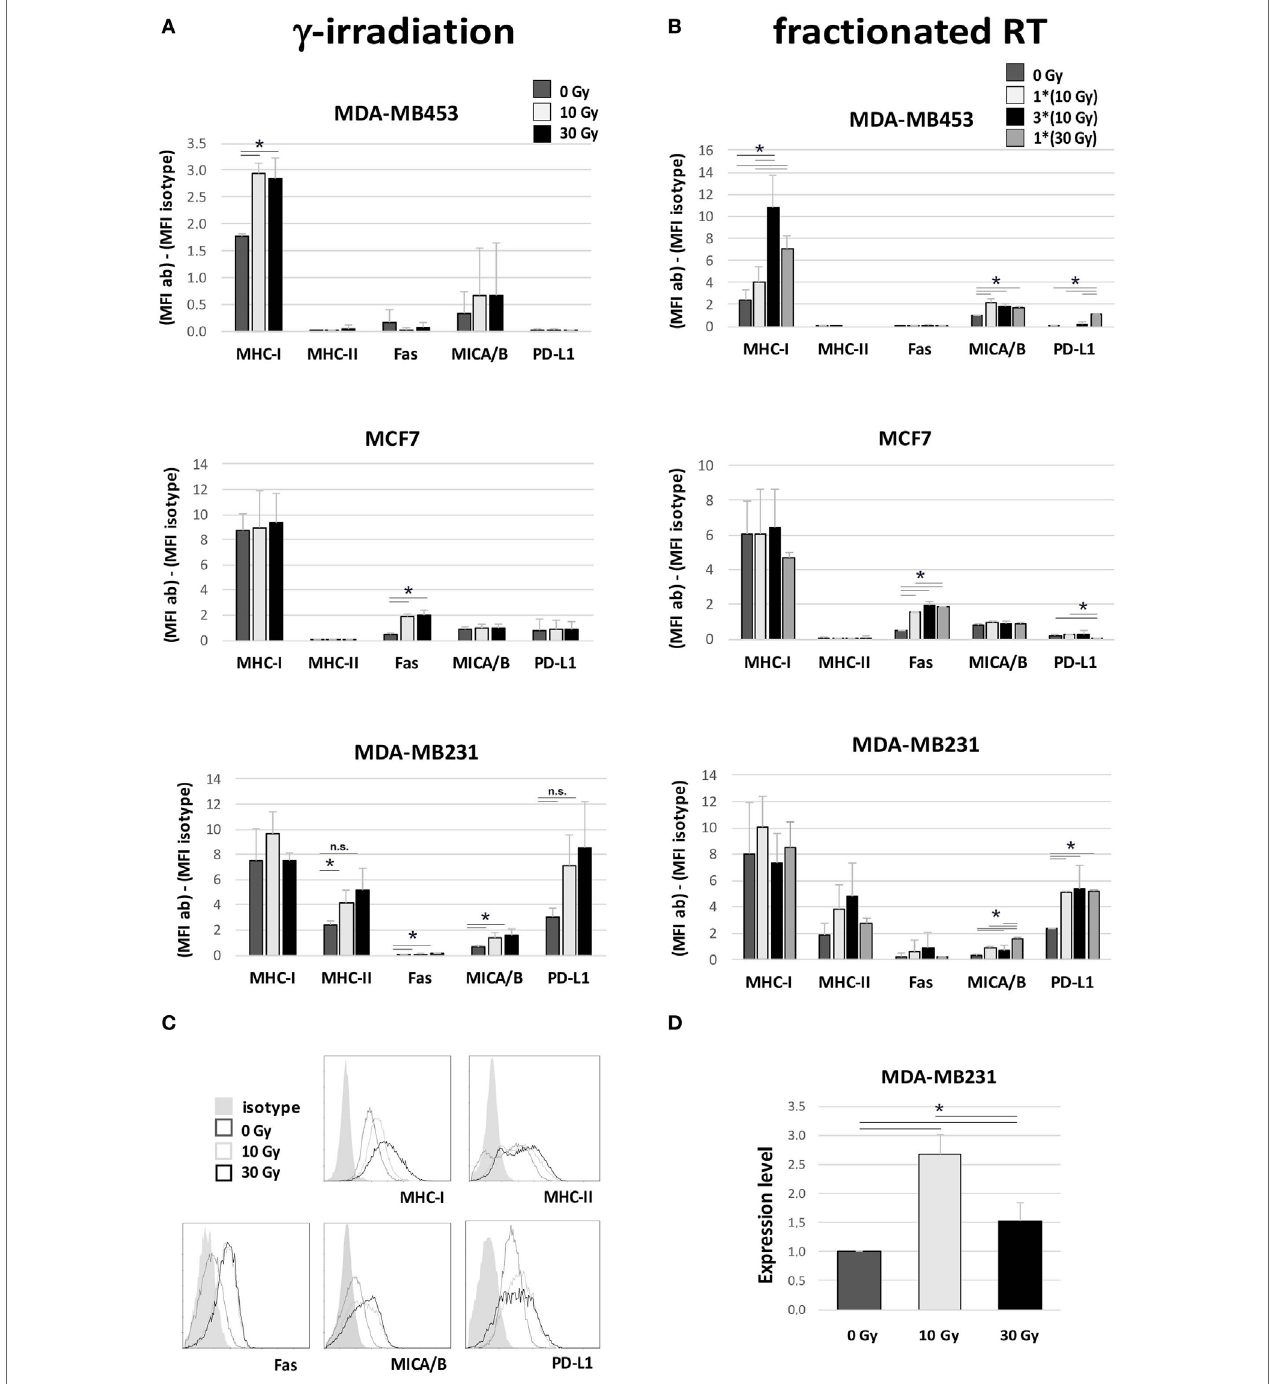
FigUre 4 | Immunomodulating effects in breast cancer (BC) in vitro models after irradiation. Flow cytometry (a–c) and gene expression (D) analyses performed in three different BC in vitro models to evaluate variations in the expression of proteins involved in the interplay between tumor cells and immune effectors, 72 h after irradiation. (a,B) Difference in mean fluorescence intensity (MFI) between target-specific antibody and isotype control in untreated sample (dark gray, 0 Gy), sample irradiated with 10 Gy (light gray), sample irradiated with 30 Gy (a) or three daily fractions of 10 Gy (B) (dark), and sample irradiated with 30 Gy through MV photon beams (gray). Data are represented as mean and SD of three independent experiments. MICA/B, MHC class I polypeptide-related sequence A and B; PD-L1, programed death ligand-1. (c) Exemplary histogram plots of flow cytometry analysis. Full curve, isotype control; dark gray curve, untreated sample (0 Gy); light gray curve, sample treated with 10 Gy; black curve, sample treated with 30 Gy. (D) Gene expression analysis of indoleamine 2,3 dioxygenase ( IDO ) in MDA-MB231 untreated (dark gray), or irradiated with 10 Gy (light gray) or 30 Gy (dark), performed by quantitative real time PCR. Data are represented as mean and SD of expression level measured in three independent experiments (* p ≤